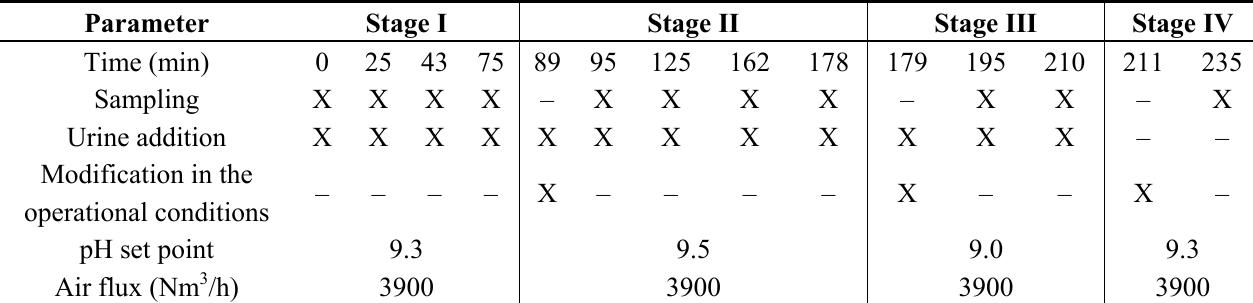
Table 3. Sample conditions and times during experiment II.